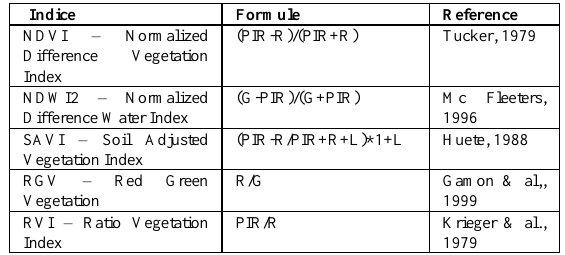
Table 1. Vegetation and water indices computed from Pleiades image.